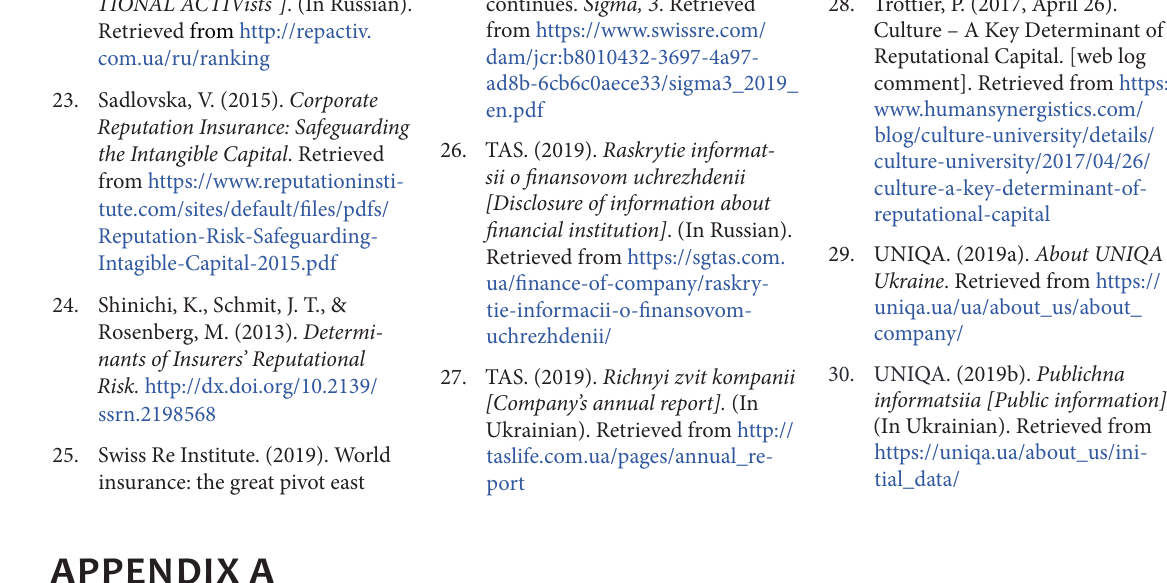
Table A1. Maximum and average insurance sums payment, UAH Name of company